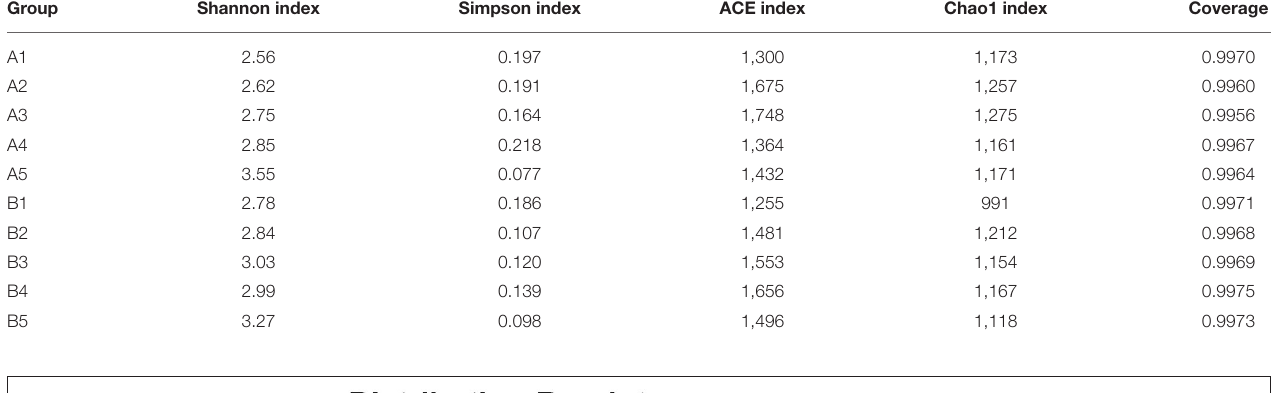
TABLE 8 | Diversity analysis of intestinal microflora in mice. Group